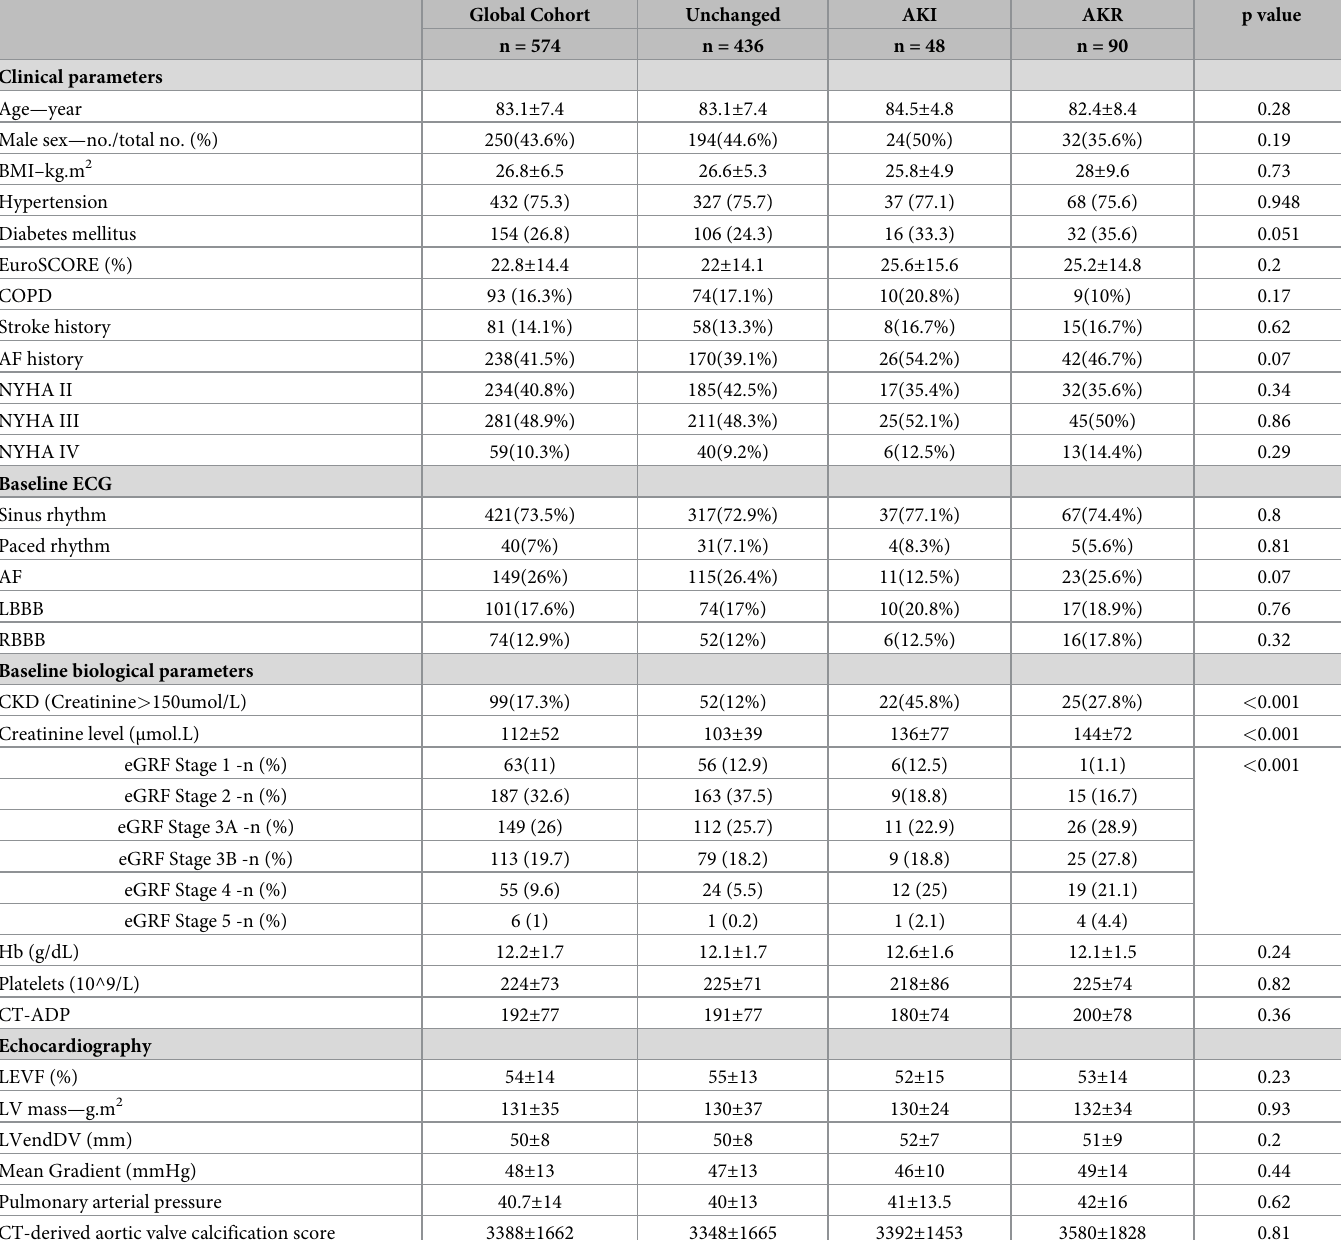
Table 1. Baseline